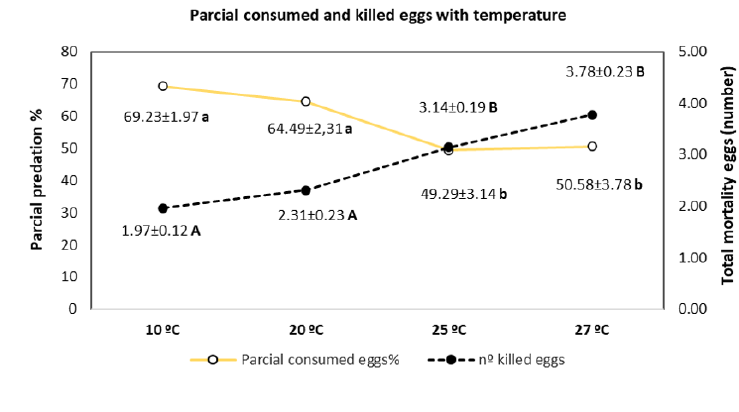
Figure 2. Mean percentage values of partial killed eggs (±SE) and number killed eggs (±SE) in the predatory potential bioassays. Values with different letters mean significant differences at p = 0.05, using the Wald test in the case of number of killed eggs and Kruskal–Wallis test for partially consumed